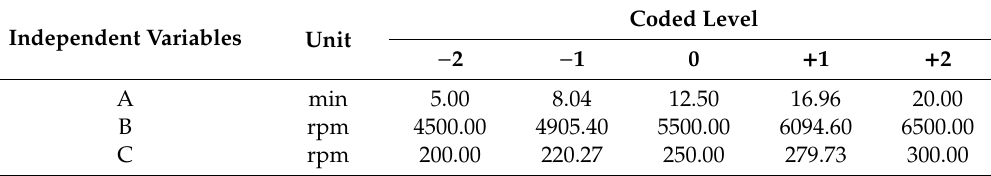
Table 9. Summary of independent variables and their coded levels.